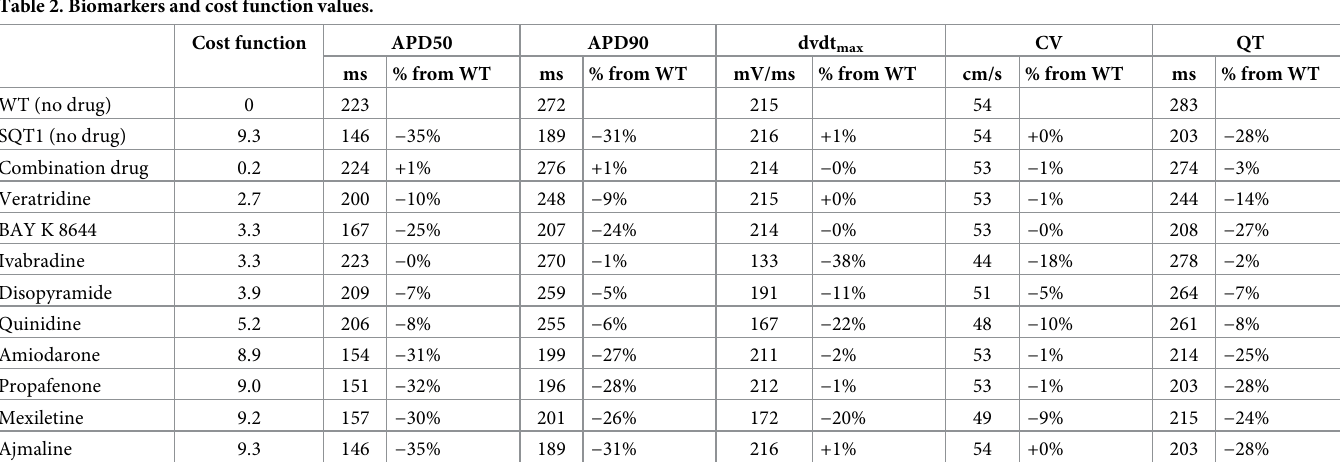
Table 2. Biomarkers and cost function values.